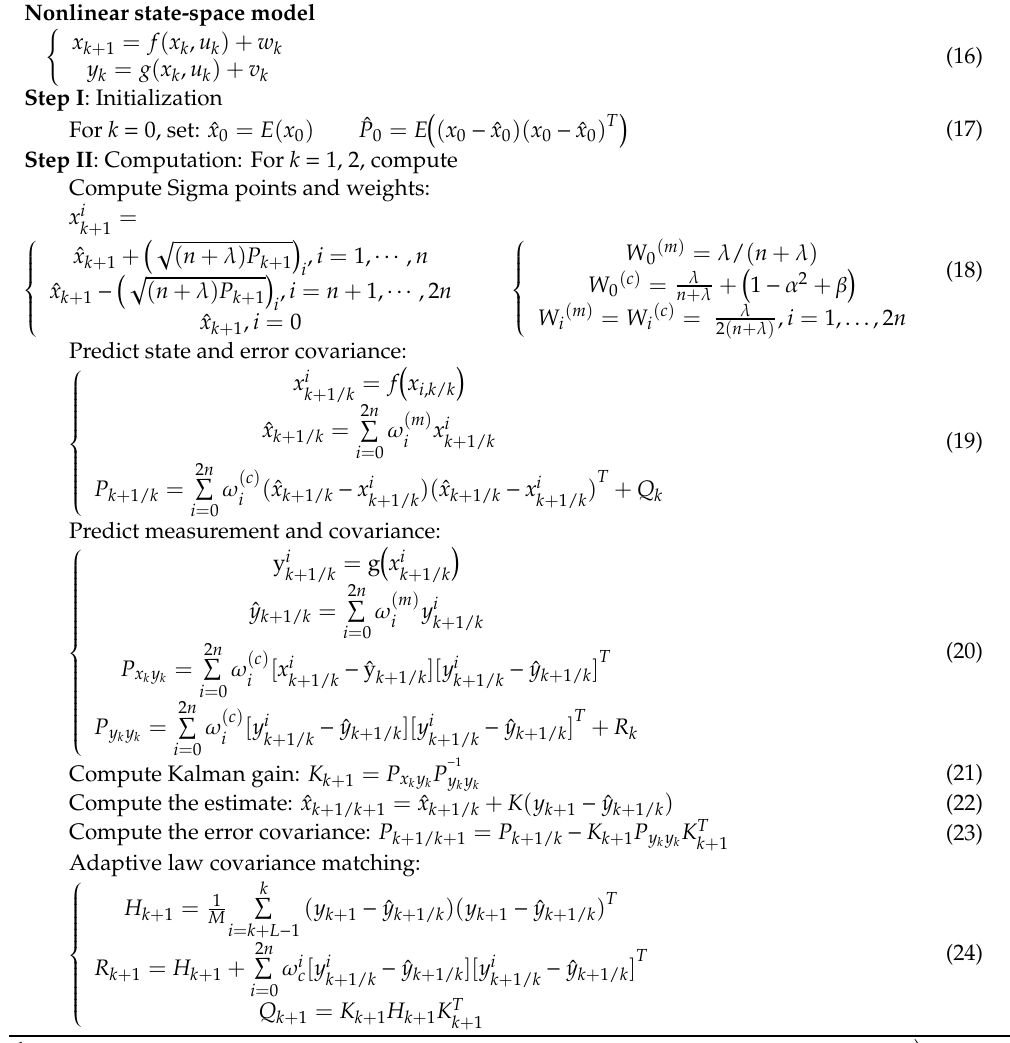
Table 1. Algorithm of adaptive unscented Kalman filter 1